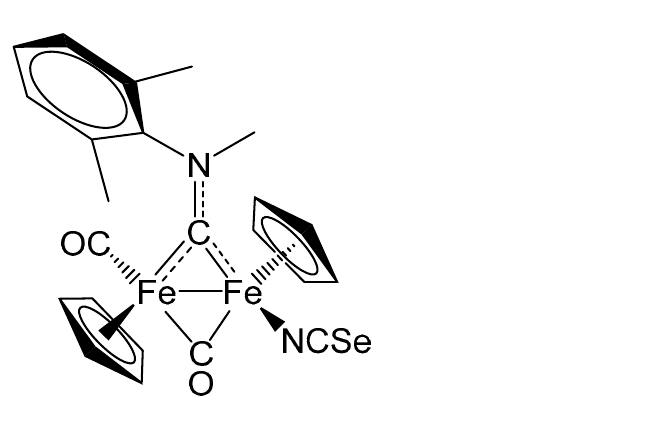
Figure 8. Structure of [Fe 2 Cp 2 (k Se ‐ SeCN)(CO)(µ ‐ CO){µ ‐ CN(Me)(Xyl)}], 4a . [Fe2Cp2(k N -NCSe)(CO)( µ -CO){ µ -CN(Me)(Xyl)}], 5a (Figure 9).